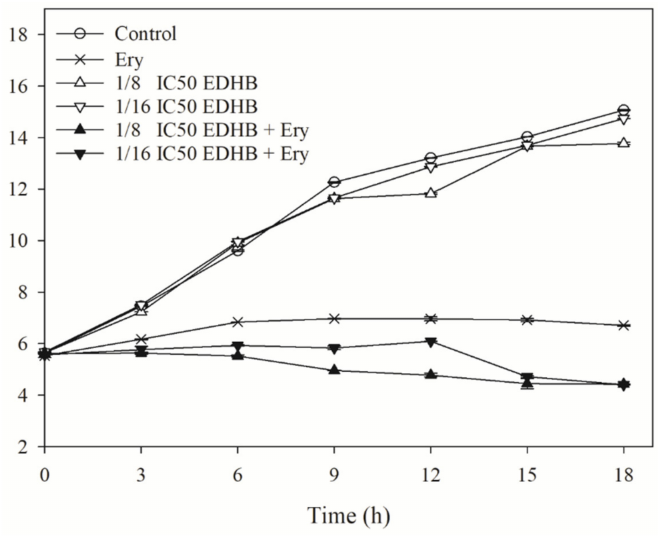
Figure 1. Time-kill curve of E. coli Kam3-AcrB with Ery, EDHB, and in combination. Ery, Ery- thromycin. Data are expressed as mean ± SD ( n =